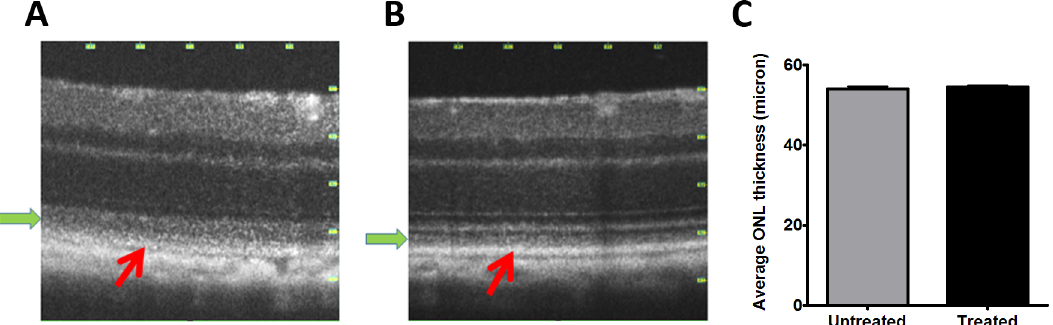
Fig 5. Zeaxanthin treatment improved structure of photoreceptor outer segments and the RPE. SD-OCT image of retinas from the zeaxanthin treated groups (n = 11) (B) after four months of treatment (6 months of age) shows preserved RPE layer and outer segment layer compared to eyes from untreated mice (n = 8) (A) of same age. We did not see any significant change in retinal outer nuclear layer (ONL) thickness (C) between control untreated and zeaxanthin-treated group. The red arrow indicates the RPE layer and the green arrow indicates the region of the photoreceptor outer segments.